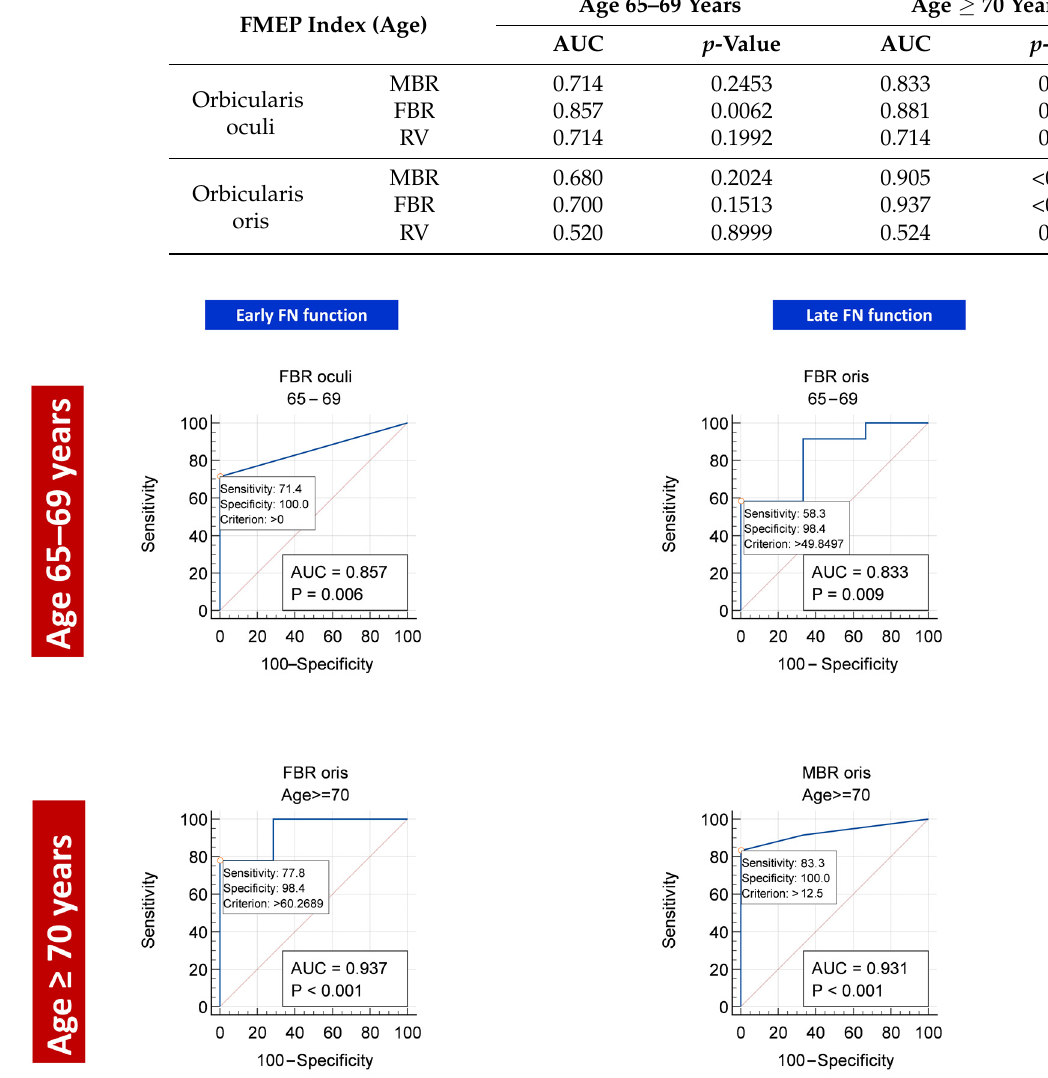
Figure 2. Best ROC curves for early ( left column ) and late FNF ( right column ) in patients aged 65–69 years ( upper row ) and ≥ 70 years ( lower row) . Table 3. Area under the curve (AUC) of ROC curves analyzing the accuracy of FMEP indices in predicting good early post-operative FN function.